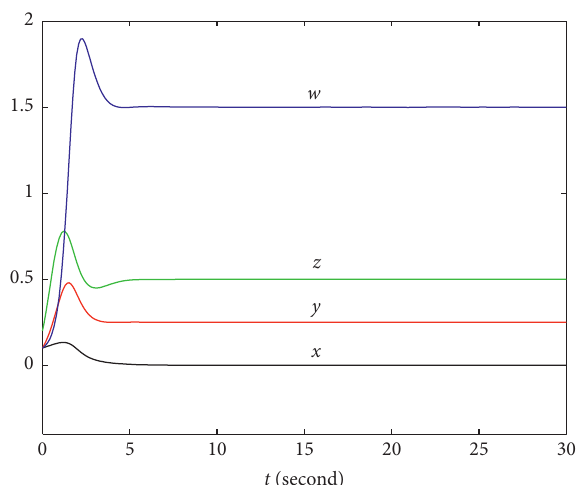
Figure 4: The values a � 0.5, b � 2, c � 3; d � 1, e � 2, f � 2, and g � 2 are used. So, we get the stable solution ( x � 0, y � 0.25, z � 0.5, and w �